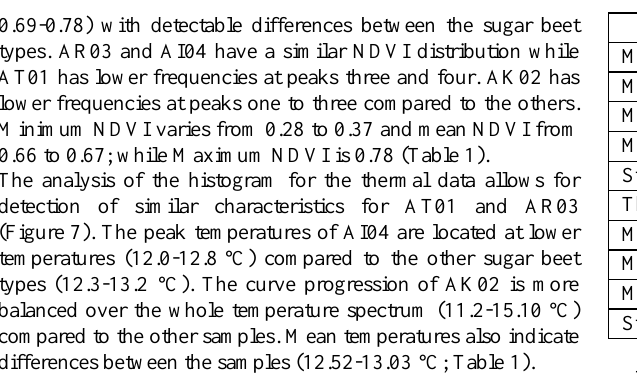
Table 1. Statistics of different sugar beet types in plot batch 2